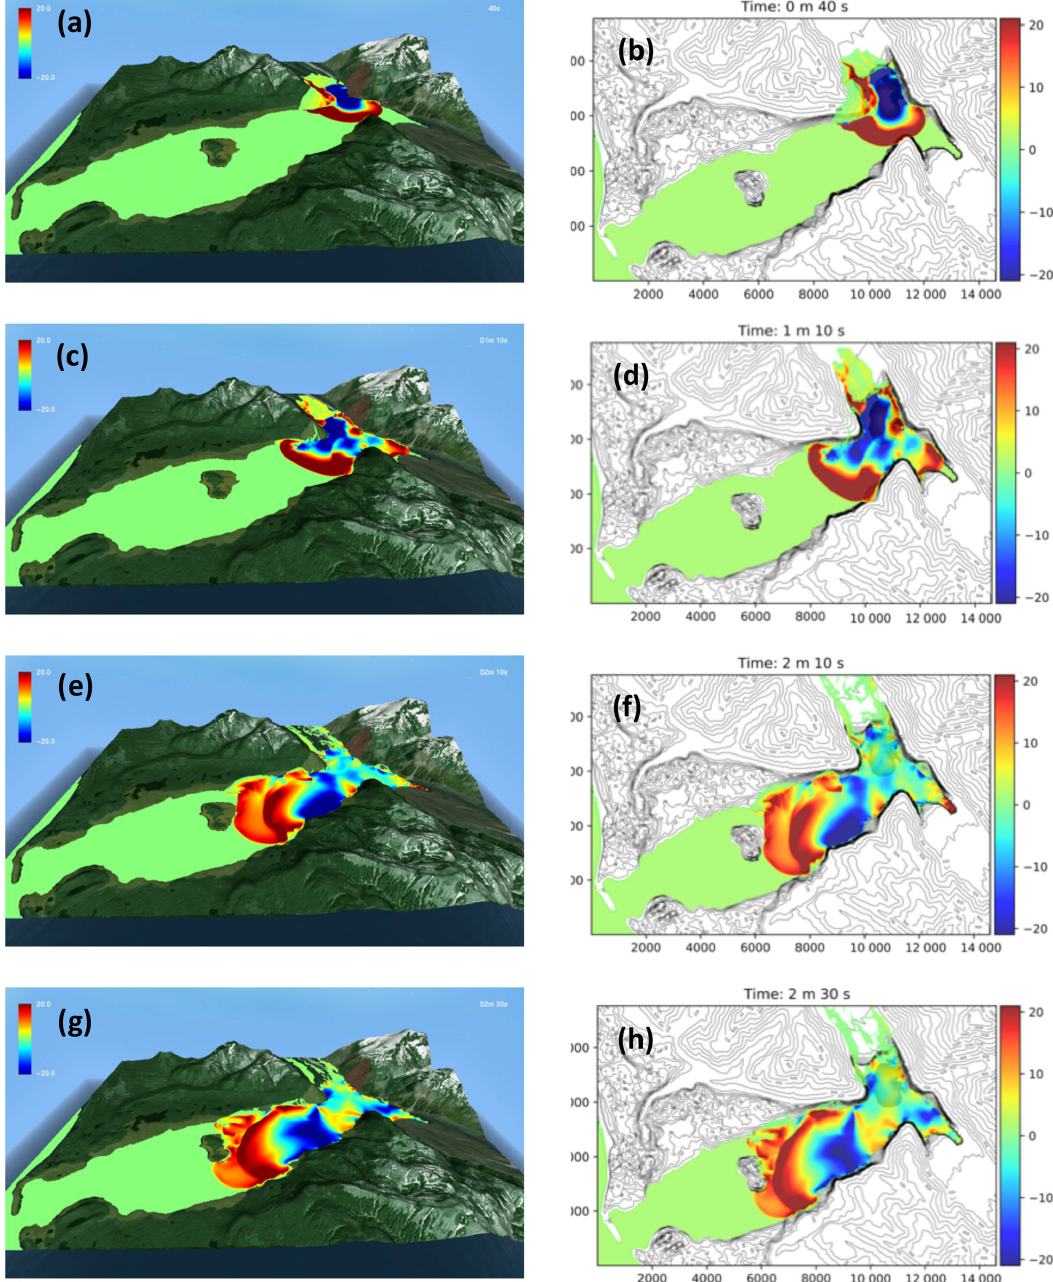
Figure 12. Wave evolution from t = 40s until t = 2min. t = 30s. In panels (b, d, f, h) the track of the inundated areas is kept. (a, c, e, g) South view; (b, d, f, h) plan